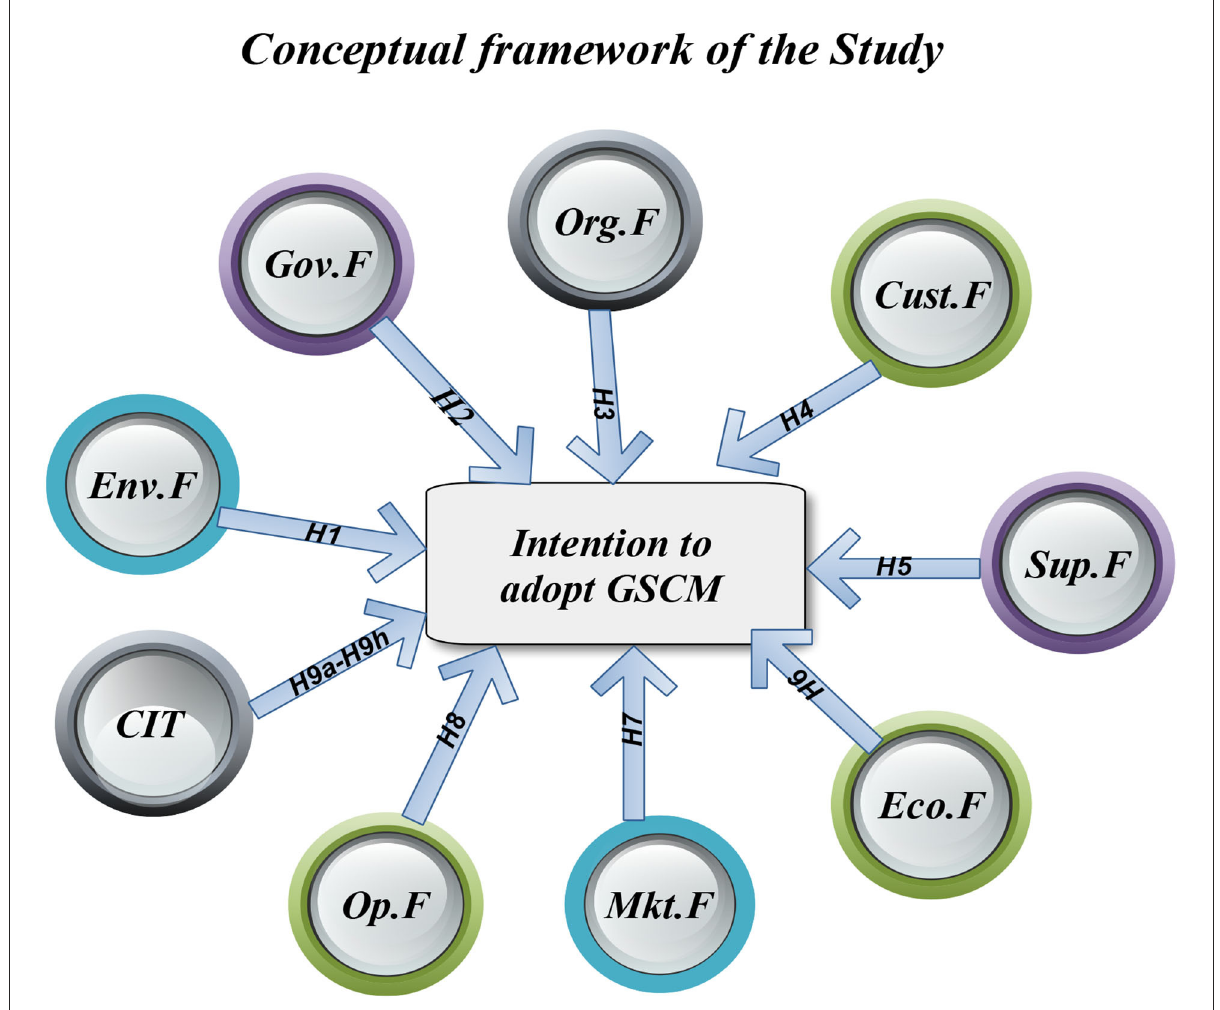
FIGURE1 The conceptual framework of the study’s hypotheses development. Env.F, Environmental Factor (H1) → Intention to adopt GSCM; Gov.F, Governmental Factor (H2) → Intention to adopt GSCM; Org.F, Organization Factor (H3) → Intention to adopt GSCM; Cust.F, Customer Factor (H4) → Intention to adopt GSCM; Sup.F, Supplier Factor (H5) → Intention to adopt GSCM; Eco.F, Economic Factor (H6) → Intention to adopt GSCM; Mkt.F, Market Factor (H7) → Intention to adopt GSCM; Op.F, Operational Factor (H8) → Intention to adopt GSCM; CIT, CIT (H9a–H9h) → Intention to adopt